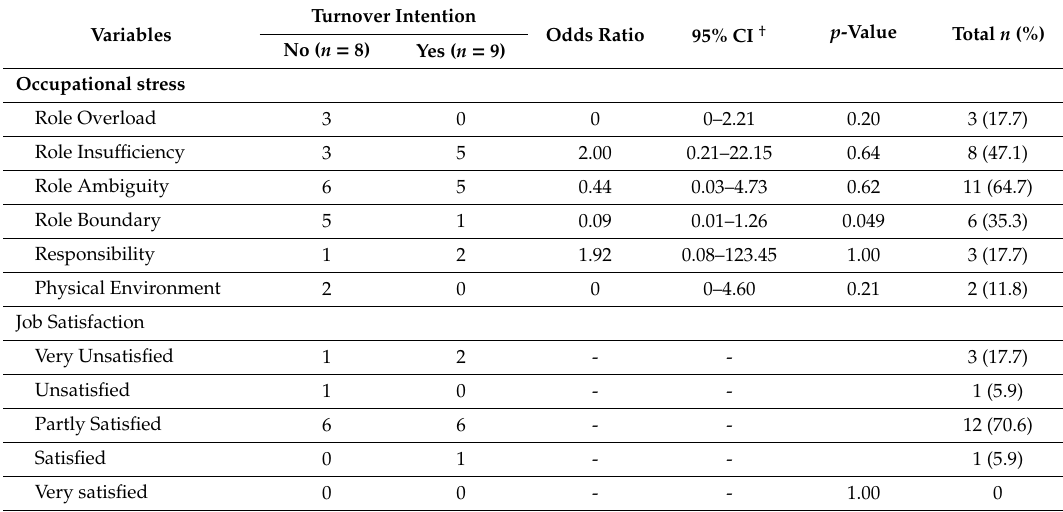
Table 2. Association between occupational stress, job satisfaction, and turnover intention.